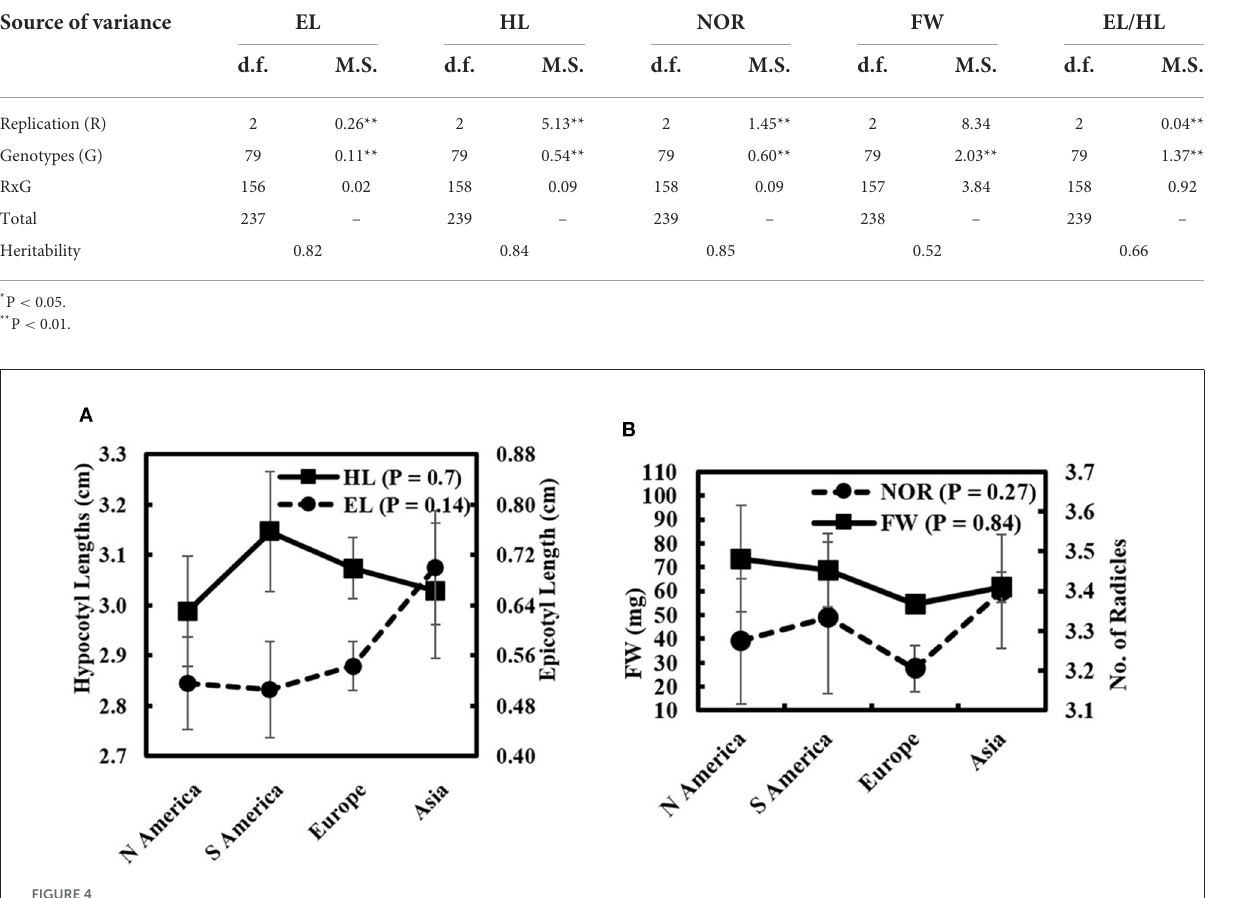
morphological, biochemical, molecular, and genetic